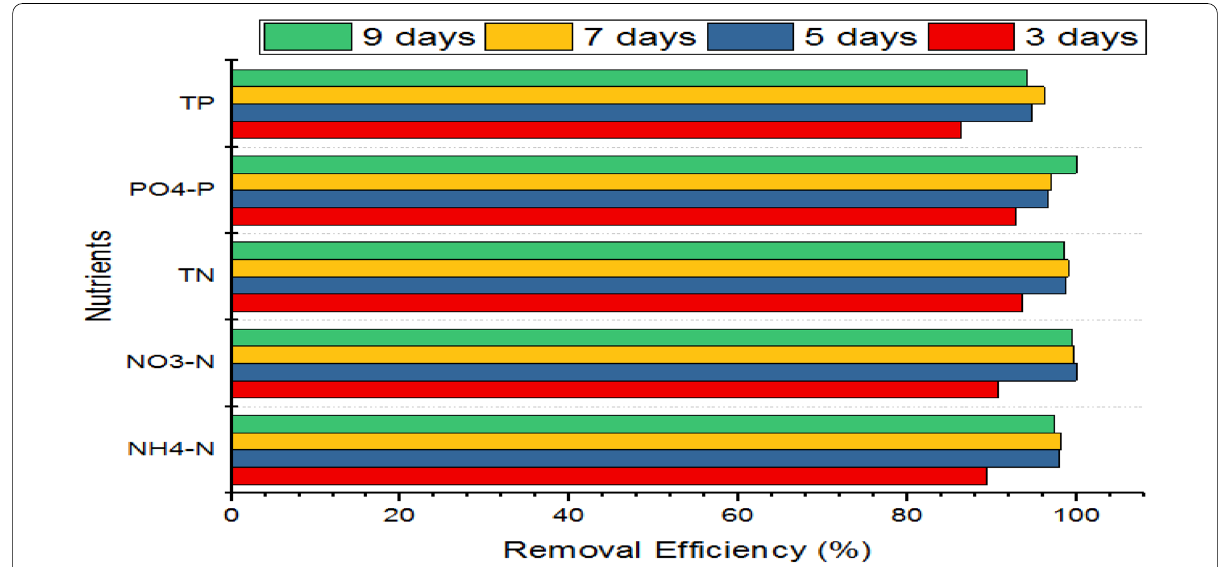
Fig. 5 Nutrient removal efficiency of pumice substrate planted with CZ at different